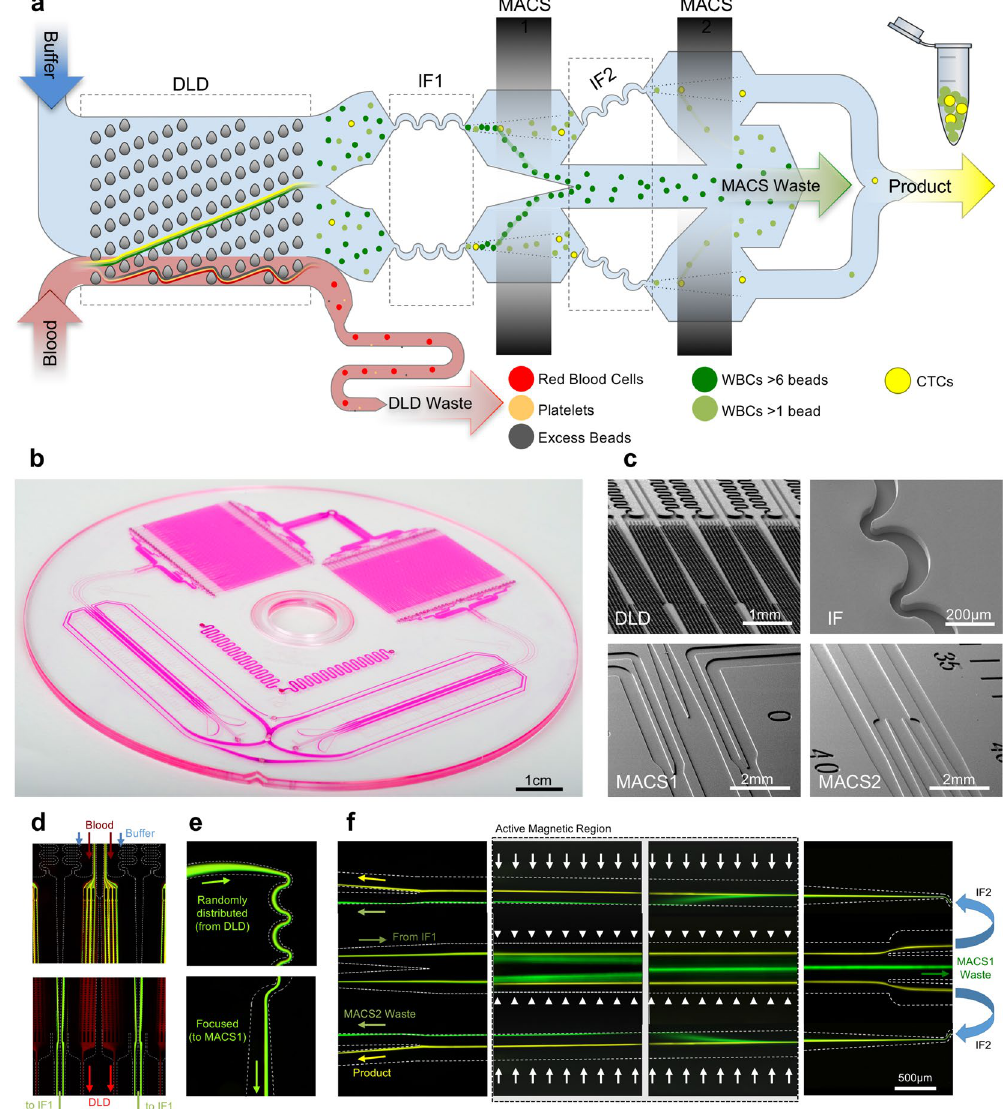
Figure 1. Device and Process Flow - ( a ) Linearized schematic of the monolithic chip and how cells are processed. ( b ) Photograph of a single chip filled with dye. ( c ) Scanning electron micrographs of important locations on the chip, top left: DLD structures, top right: Inertial focusing units, bottom left: MACS1 inlet merge and MACS 2 outlet, and bottom right MACS2 inlet and MACS1 outlet split. Blood pre-labeled with antibodies and magnetic beads targeting white blood cells and buffer enter the device and first go through a deterministic lateral displacement (DLD) device that separates nucleated cells from the red blood cells, platelets and unbound magnetics beads. These cells are then accelerated through an inertial focusing device (IF1) that causes the alignment of the cells without the addition of a sheath flow. These aligned cells merge into a single channel and then pass through a magnetic field where the high gradient forces magnetically tagged cells towards the center of the channel (MACS1). This channel then splits collecting highly tagged cells in the center waste and all remaining cells are refocused in a second inertial focusing device (IF2) and then enter a different region of the magnetic field where the gradient is higher leading to the removal of all labeled cells (MACS2). ( d ) Operational images of the different microfluidic components on the chip starting on the left with the DLD device where WBCs and CTCs are labeled green and RBCs are labeled red. The RBCs, WBCs and CTCs enter together along with a buffer co-flow (top). RBCs and smaller items pass straight through the array while the WBCs and CTCs are bumped across the array into a buffer co-flow and can be separated by splitting the flow streams at the outlet (bottom). ( e ) Next the WBCs and CTCs enter the inertial focusing channels where they begin as a diffuse stream (top) and exit in a tightly aligned fashion. ( f ) The last images on the righty show the flow of two inertial focusing channels (one half of the entire chip) (middle) flowing from left to right going through the low magnetic gradient region and achieving partial separation. The streams are split and the CTCs with few WBCs are refocused (not shown) and enter the second high gradient MACS region flowing from right to left. The now purified product of CTCs (yellow) is split from the WBCs stream at the